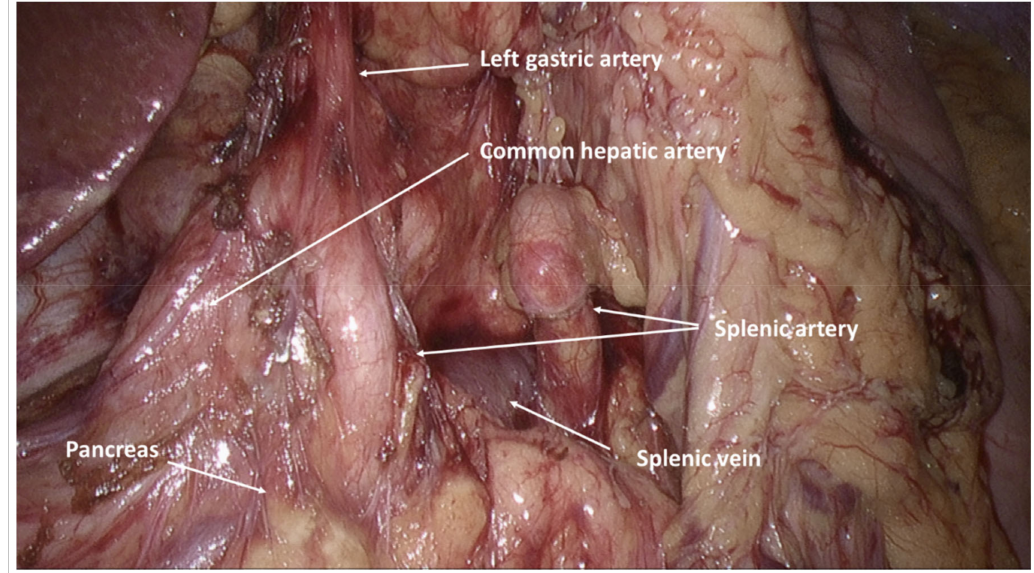
Figure 2. Intraabdominal view after performed pancreas- and spleen-preserving